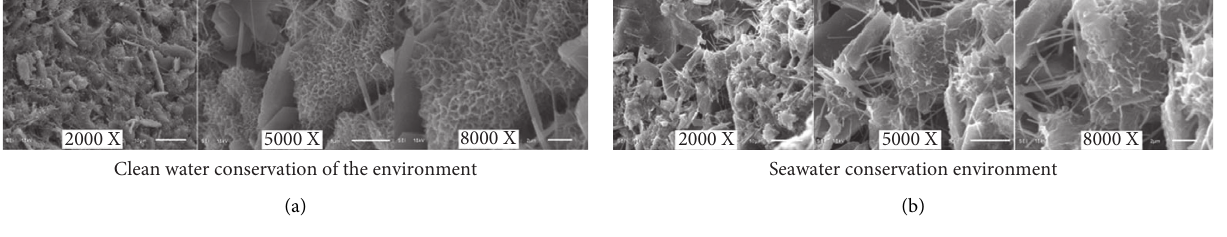
Figure 3: Microstructure of 225d sand layer grouting plus solids curing. (a) Clean water conservation of the environment. (b) Seawater conservation environment.